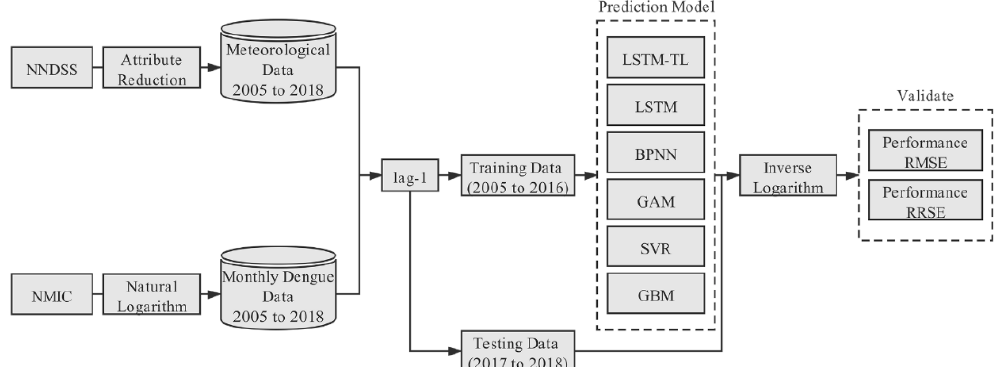
Figure 2. Summarized workflow for the construction of the LSTM-based forecasting model for dengue cases and its comparison with other candidate models. NNDSS: National Notifiable Disease Surveillance System; NMIC: National Meteorological Information Center; BPNN: Back Propagation Neural Network; GAM: Generalized Additive Model; SVR: Support Vector Regression; GBM: Gradient Boosting